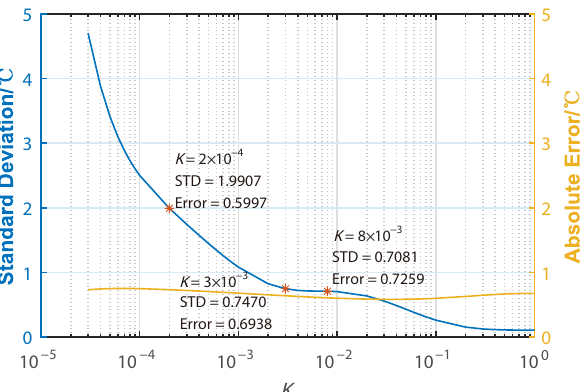
Figure 10. Evolution of the standard deviation and absolute error of the resolved temperature distribution around the heated 9-m fiber coil over parameter K